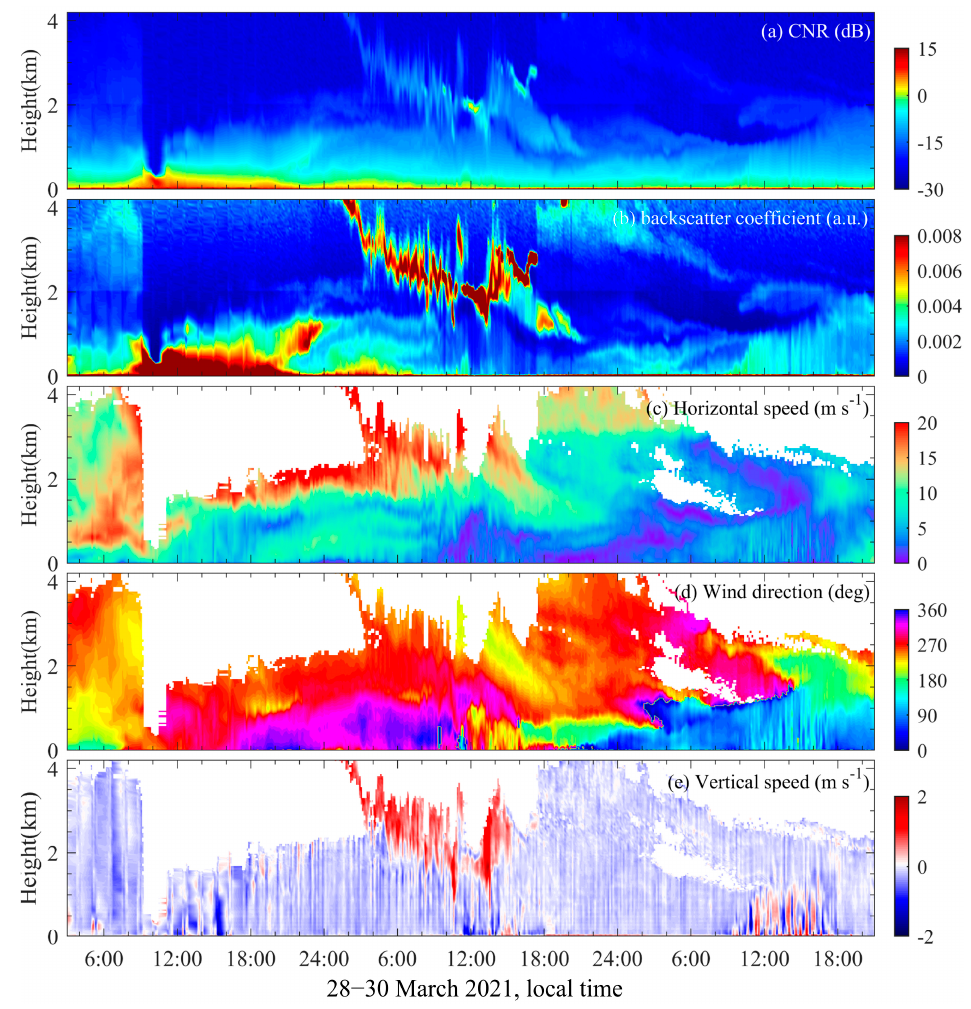
Figure 5. A dust storm episode detected by CDWL from 28 to 30 March, 2021. ( a ) CNR, ( b ) backscatter coefficient, ( c ) horizontal wind speed, ( d ) horizontal wind direction, ( e ) vertical wind speed. The CNR and backscatter coefficient are averaged in a vertical scanning. Positive value of vertical velocity is defined as downward.